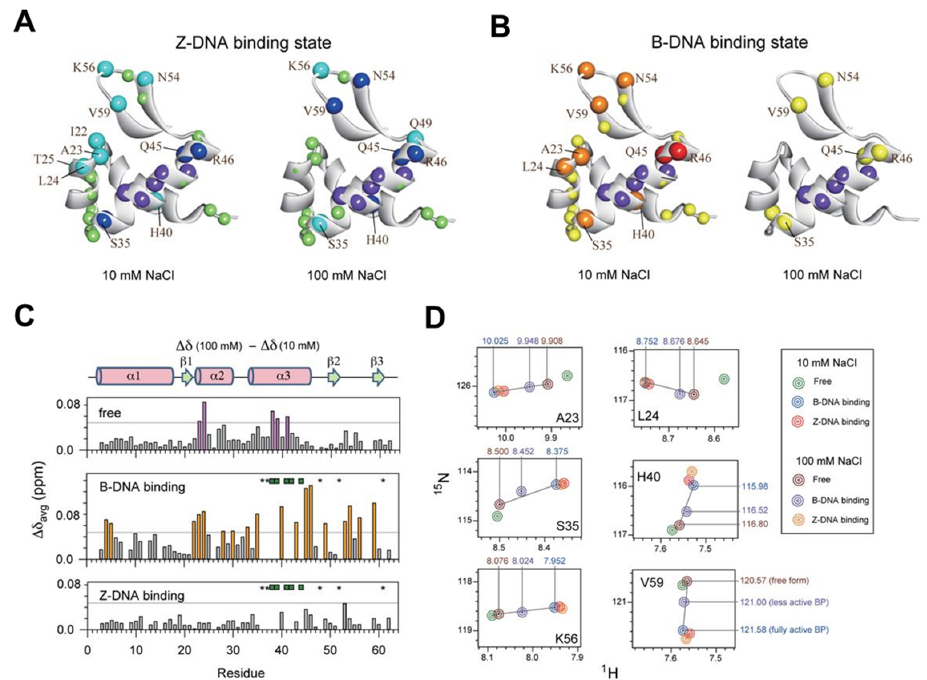
Figure 8. ( A,B ) DNA binding patterns of (A) Z-DNA and (B) B-DNA binding at 10 (left) or 100 mM NaCl (right). Chemical shifts are illustrated by different colors: red or blue, >0.18 ppm; orange or cyan, 0.12–0.18 ppm; and yellow or pale green, 0.08–0.12 ppm.The purple spheres indicate sites with disappeared or very weak cross-peaks during titration. ( C ) The average chemical shift differences between [NaCl] of 10 and 100 mM with free caZ α PKZ (upper) and caZ α PKZ – B-DNA (middle) and Z-DNA (lower) complex ( D ) The calculated 1 H- 15 N HSQC cross-peaks of caZ α PKZ – B-DNA or Z-DNA complexes in 10 or 100 mM NaCl solutions.